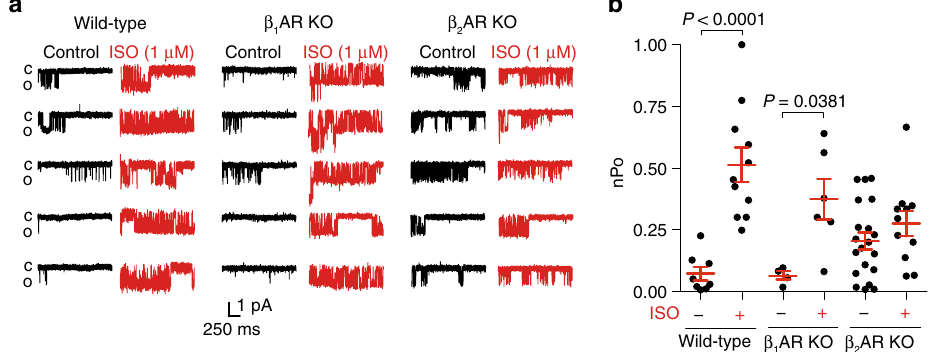
Fig. 6 β 2 AR is necessary for ISO-induced upregulation of LTCC Ca v 1.2 activity in hippocampal neurons. a Representative single-channel recordings of LTCC Ca v 1.2 currents in hippocampal neurons from wild type (WT), β 1 AR knockout (KO) and β 2 AR KO mice at 7 – 14 DIV after depolarization from − 80 to 0 mV without (black traces) and with stimulation of 1 μ M ISO (red traces) in the patch pipette. b Data in a were quanti fi ed and plotted. The